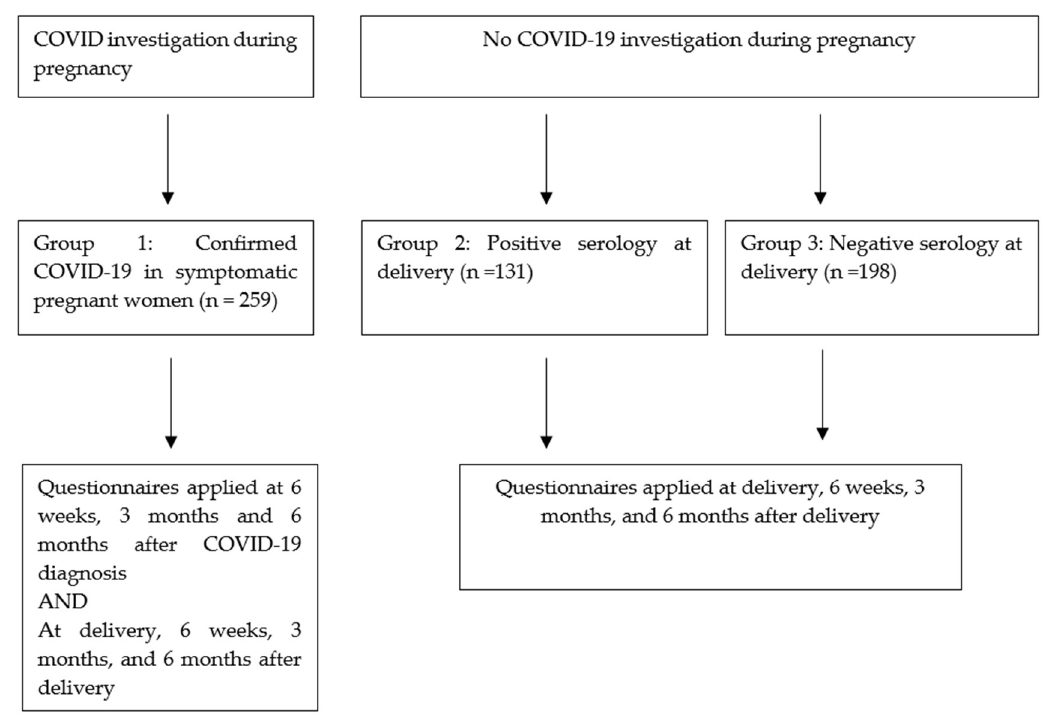
Figure 1. Details on each group, its size, and times of questionnaire application.